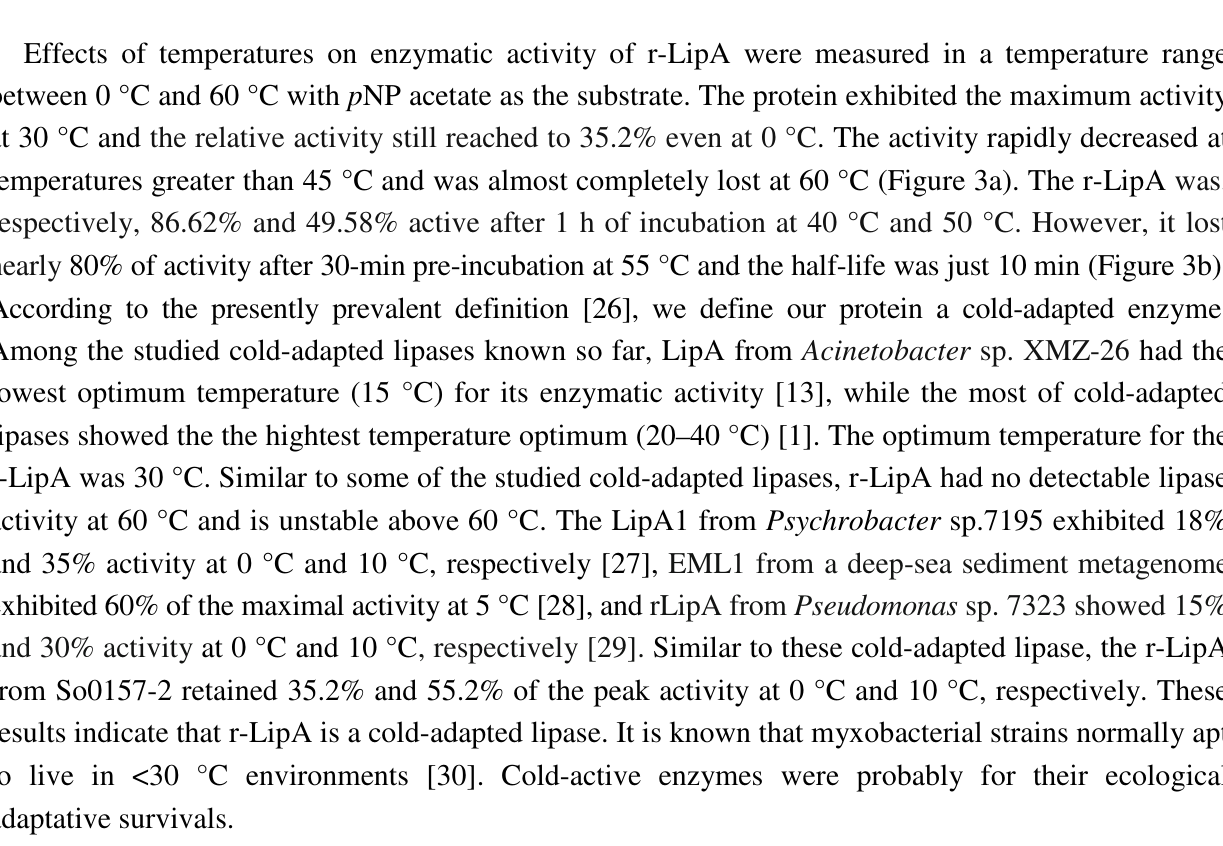
Figure 3. Effects of temperature on activity and stability of the r-LipA. ( a ) Effect of temperature on r-LipA activity. Enzymatic activity of purified lipase (0.5 mg/mL) was determined in a temperature range of 20–60 °C in 50 mM Tris-HCl (pH 8.0); ( b ) Thermostability of r-LipA. The enzyme was pre-incubated at 40 °C (filled square), 50 °C (empty square), 55 °C (filled triangle), or 60 °C (empty triangle) in 50 mM Tris-HCl (pH 8.0), and aliquots were withdrawn at regular intervals to measure residual activity at 30 °C. All measurements were carried out in